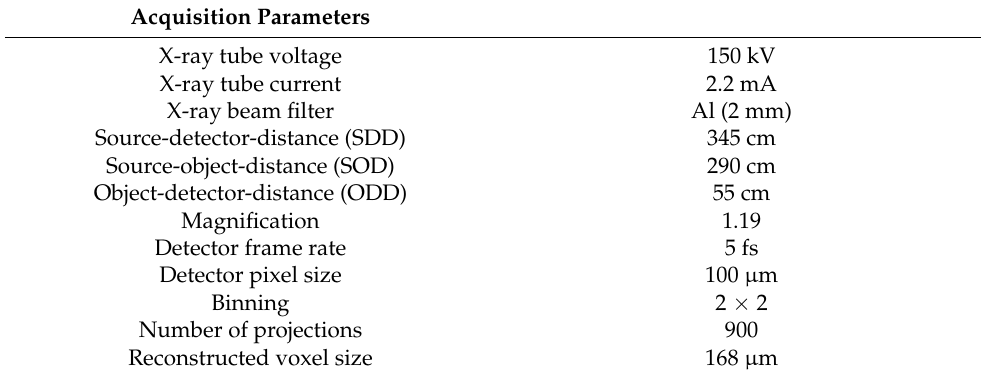
Table 1. Main acquisition parameters for the CT analysis of Un-Montu’s